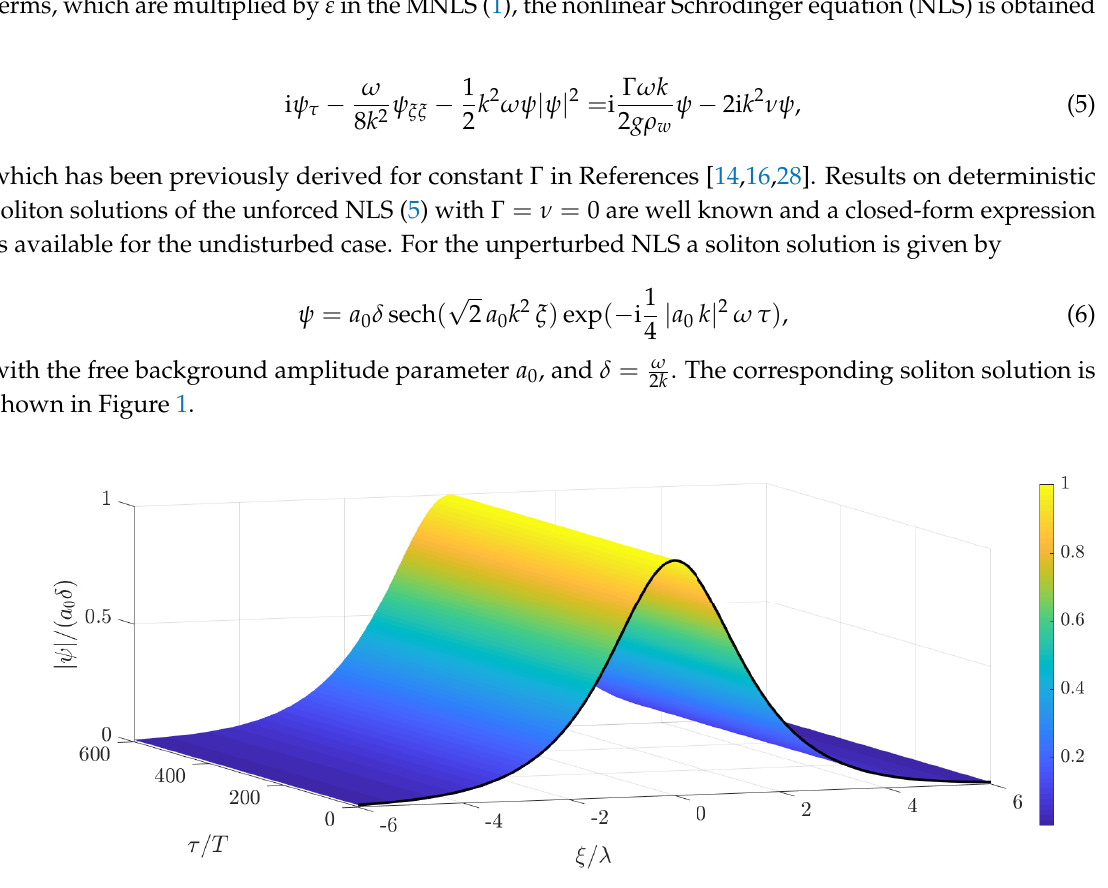
Figure 1. Temporal evolution of a soliton solution of the unforced nonlinear Schrödinger equation (NLS) (5) with Γ = ν =